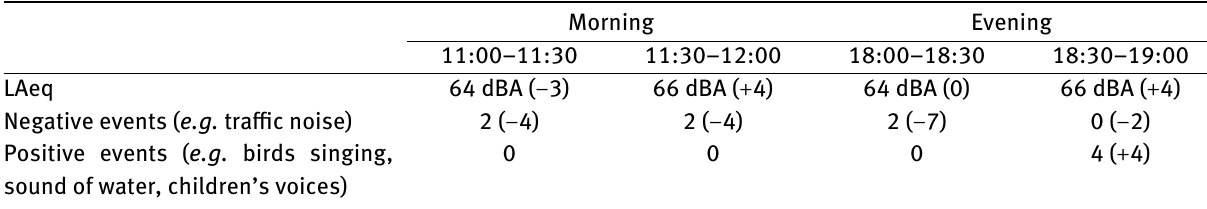
Table 2: Noise levels (LAeq) and noise events evaluated in General La Torre square for the post-operam phase (in brackets the difference between the post and the ante-operam scenario).